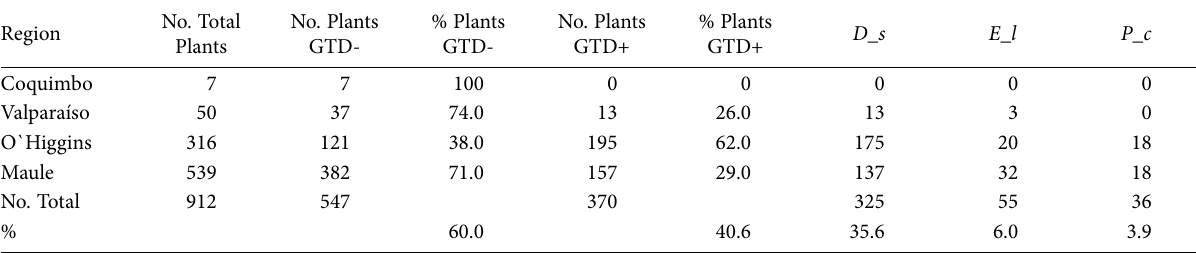
Table 2. Incidence of GTD pathogens by region in Chile. The regions are ordered from north to south of the country. No. = number, GTD- = plants with no GTD fungi, GTD+ = plants with GTD fungi. D_s = Diplodia seriata , E_l = Eutypa lata and P_c = Phaeomoniella chlamydo- spora . The number below each GTD fungus corresponds to the number of positive plants infected by that fungus. Region